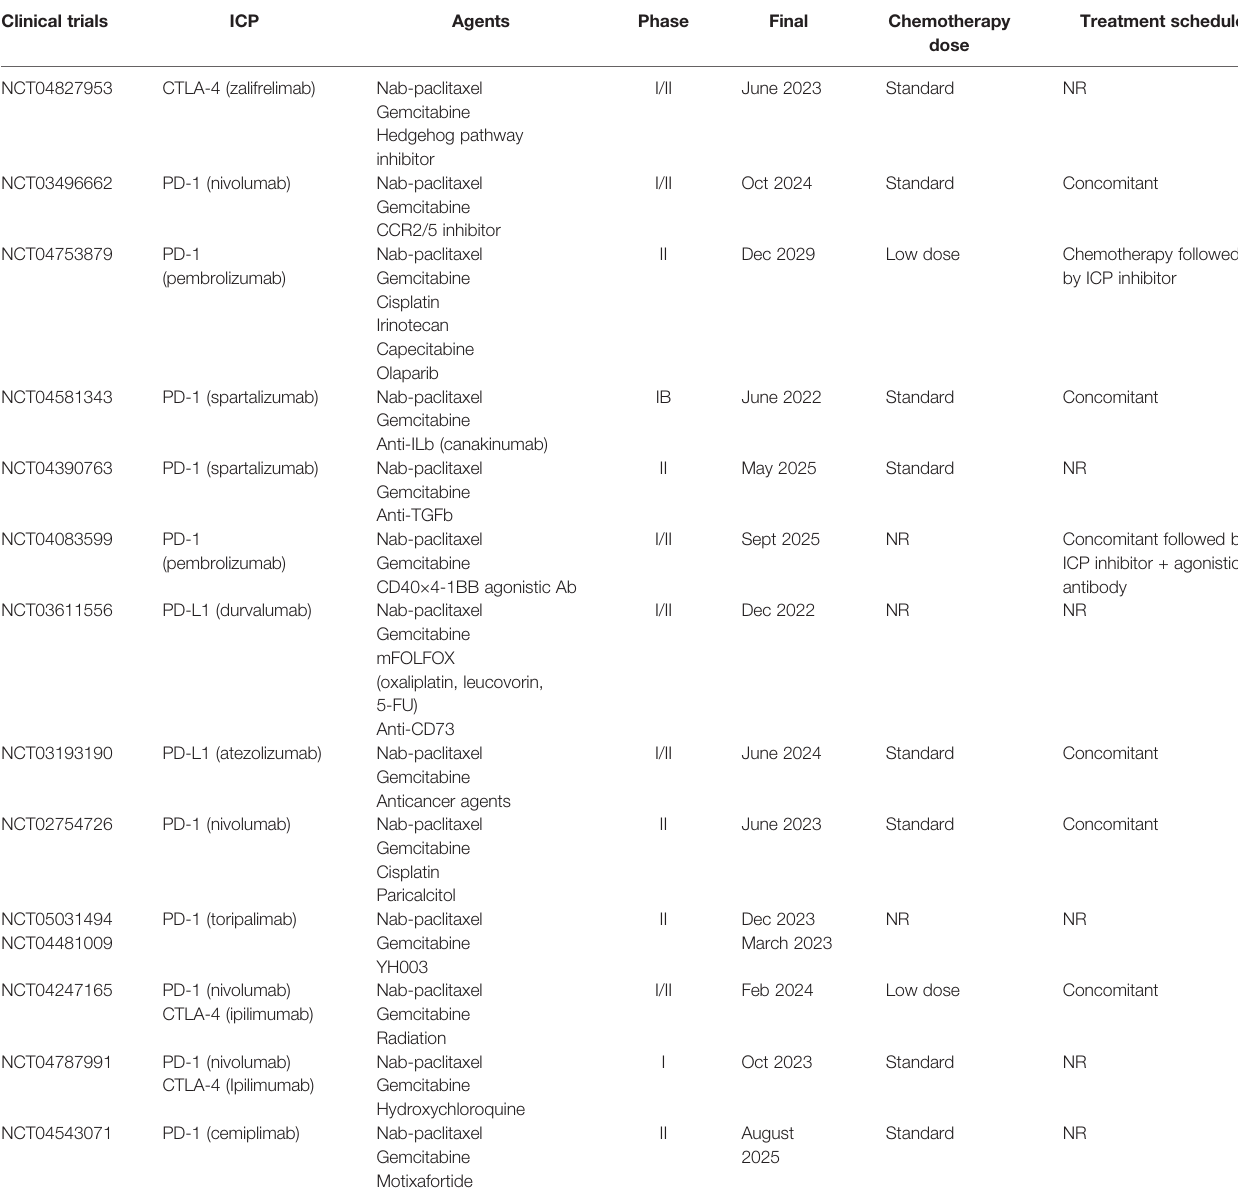
TABLE 2 | Ongoing clinical trials in PDAC using chemotherapy in combination with immune checkpoint with associated doses and schedules. Clinical